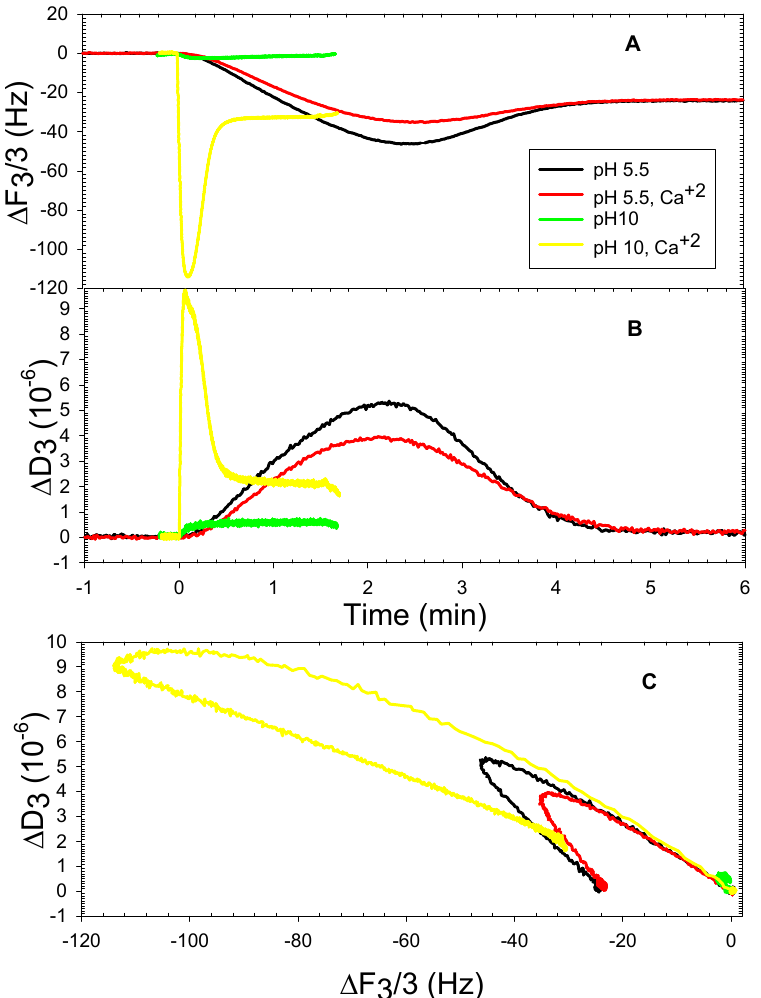
Figure 6. Representative QCMD frequency ( A ) and dissipation ( B ) shifts of DOPC adsorption onto silica at pH 5.5 and pH 10 in the absence and presence of 2 mM CaCl 2 ; ΔF vs. ΔD plot ( C ).